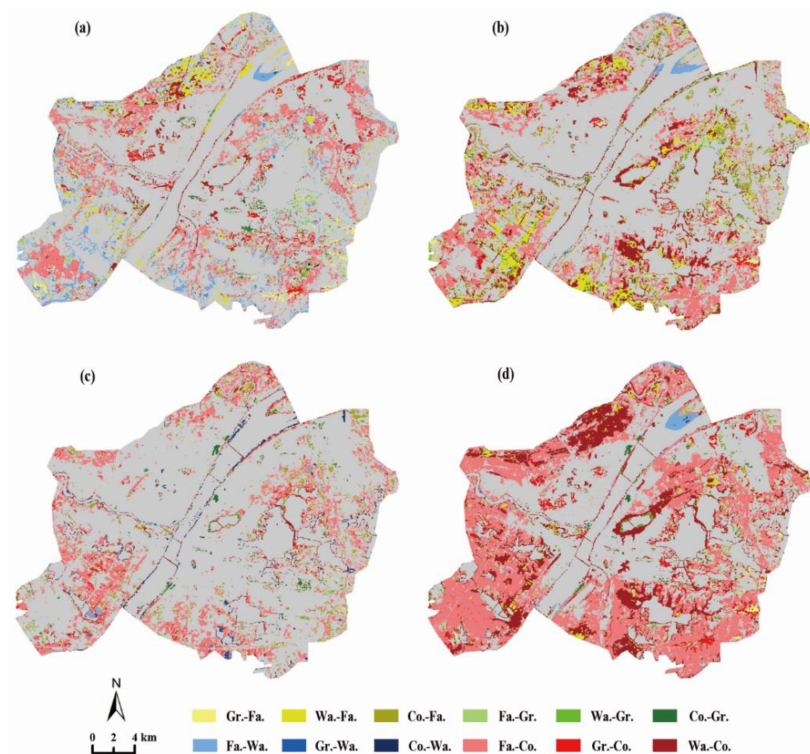
Figure 5. LULC transition maps during 1987–1996 ( a ), 1996–2007 ( b ), 2007–2016 ( c ) and 1987–2016 ( d